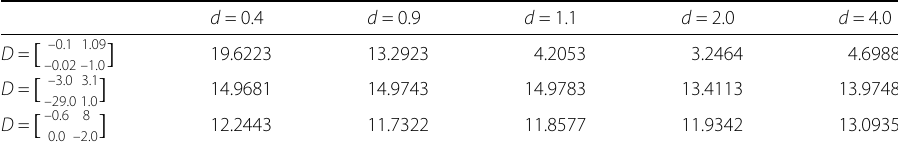
Table 1 Maximal allowable upper bounds of τ 1 for different parameter D d = 0.4 d = 0.9 d = 1.1 d = 2.0 d = 4.0 (cid:18) (cid:17) –0.1 1.09 D = –0.02 –1.0